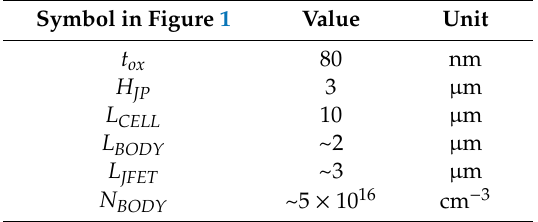
Table 1. Key geometrical parameters and doping concentrations for device design.